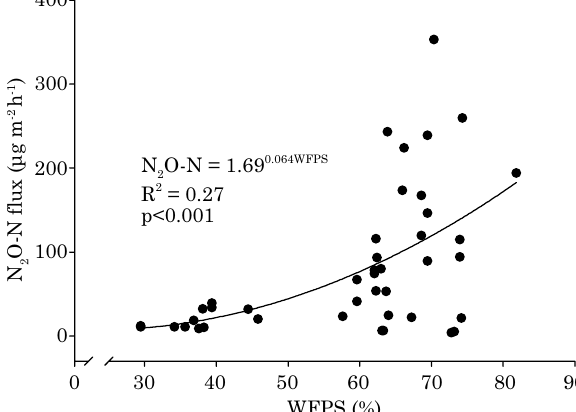
Figure 4. Relationship between soil water-filled pore space (WfPS) and N 2 o-N emission after sheep urine and dung application in a subtropical Argissolo Vermelho Distrófico típico (typic Paleudult) under italian ryegrass